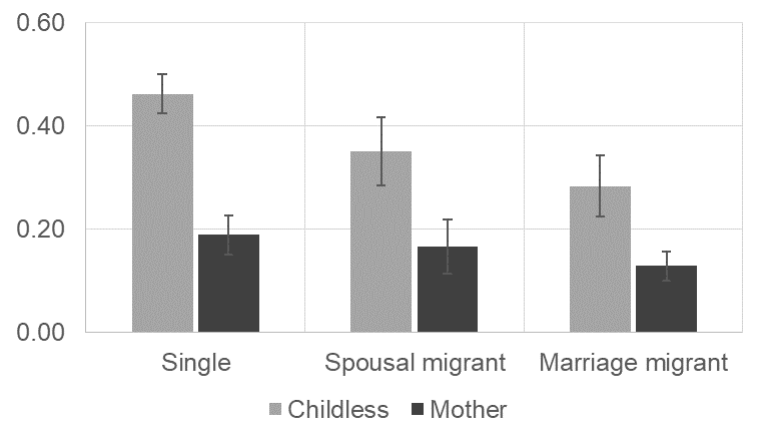
Figure 3 : Predicted annual probabilities of an interaction model that distinguished between childless women and mothers in each migration pattern